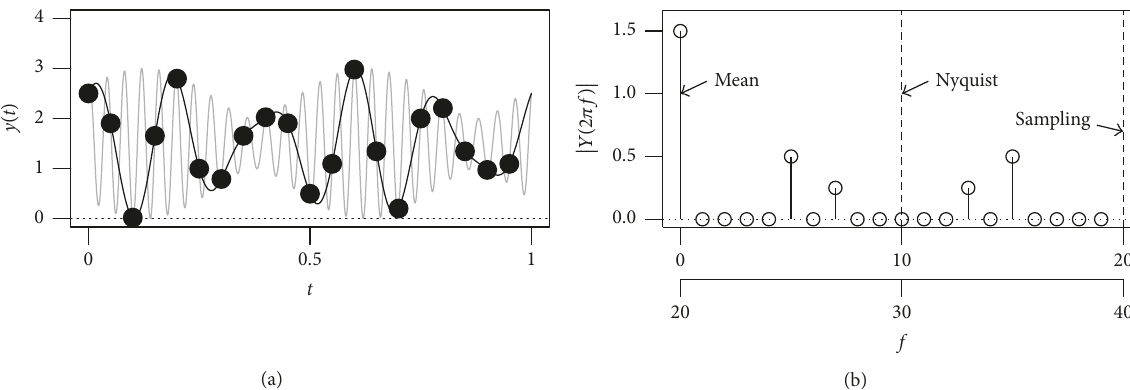
Figure 4: A signal with a limited bandwidth is sampled times slower than the signal frequency. The black line in (a) displays again the second possible curve, which would map to the spectrum in